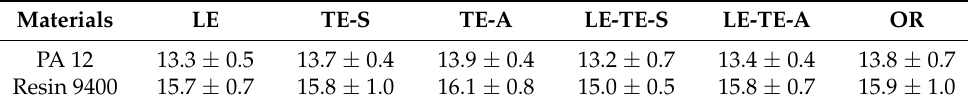
Figure 5. Different 3D printing rotors with PA 12 and Resin 9400, respectively. ( a ) OR and bionic rotors with PA 12; ( b ) OR and bionic rotors with Resin 9400. Table 4. Weight comparison of 3D printing rotors with PA 12, Resin 9400, and CFRP. Unit: g.